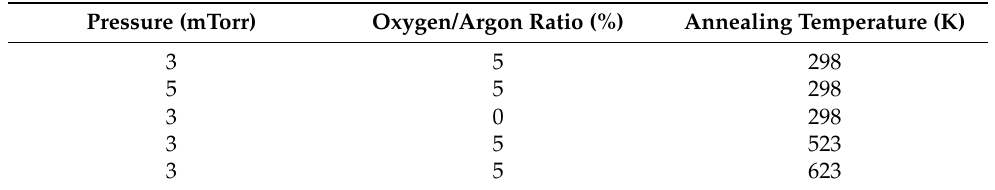
Table 1. Different conditions for ZATO thin films fabrication.